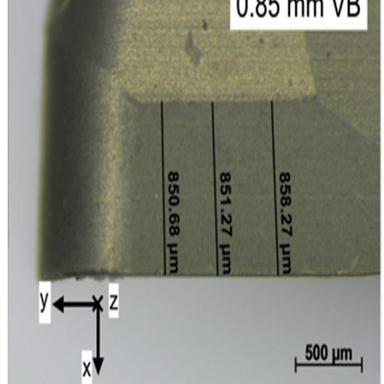
Micrographs of the cutting inserts: The location and direction of the material removal from the grinding process used to prepare "worn" inserts (a). The two different levels of flank wear on the inserts (b,c).